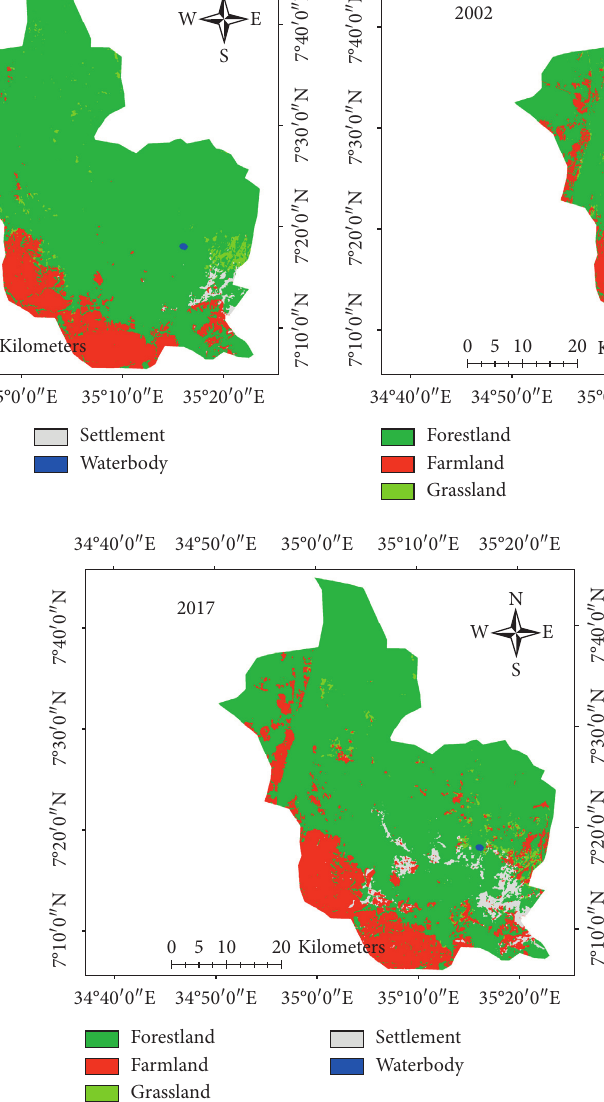
Figure 5: LULC of 1987, 2002, and 2017 in